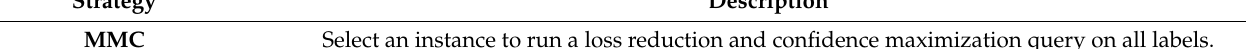
Table 1. Multi-label query strategies. Strategy Description Random